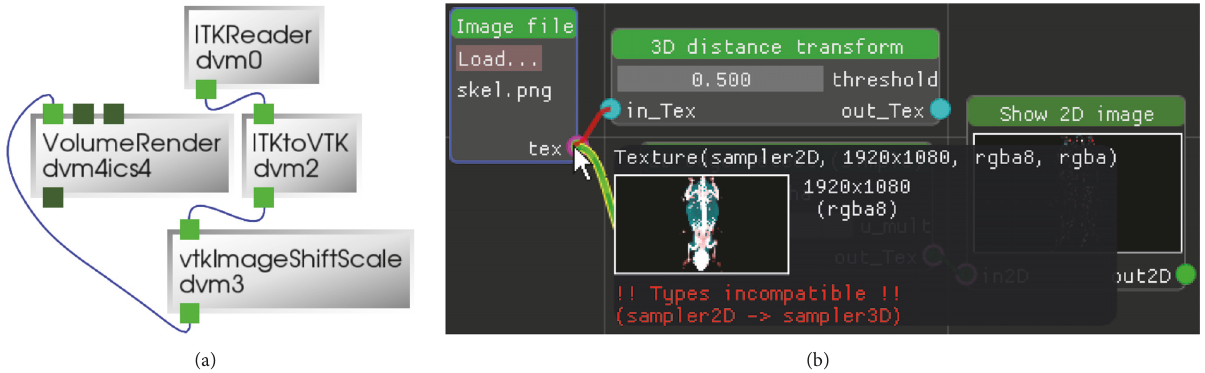
Figure 6: Comparison of our graph editor (b) with the interface of DeVIDE (a). Our graph editor shows a lot more detail, including a preview when hovering in-/outputs if possible. It also checks for misuse, that is, ensures connector type compatibility and prevents cycles. The depicted DeVIDE graph did not work, despite trying multiple variants. There was no sign of error when building the graph.